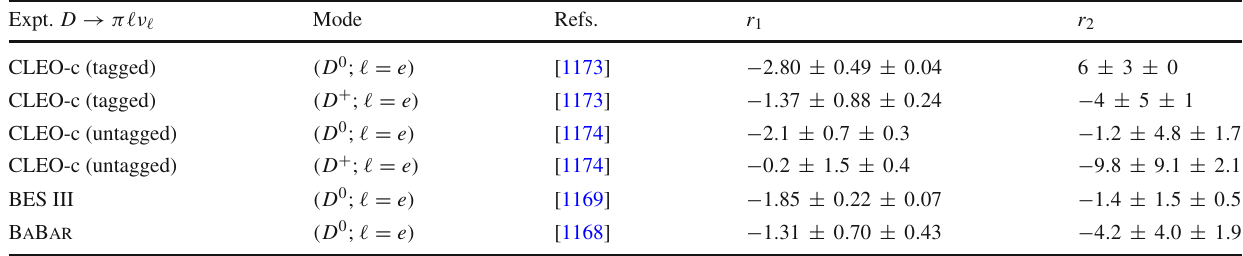
Table 274 Results for r 1 and r 2 from various experiments, for D → π(cid:12)ν (cid:12) . The correlation coefficient between these parameters is larger than